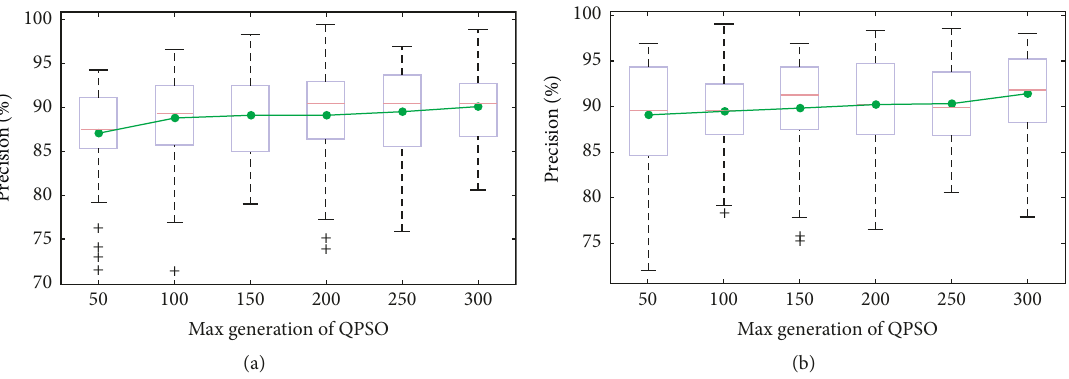
Figure 15: Prediction precision versus max generation of QPSO. (a) Ratio of training set � 60%; (b) ratio of training set �